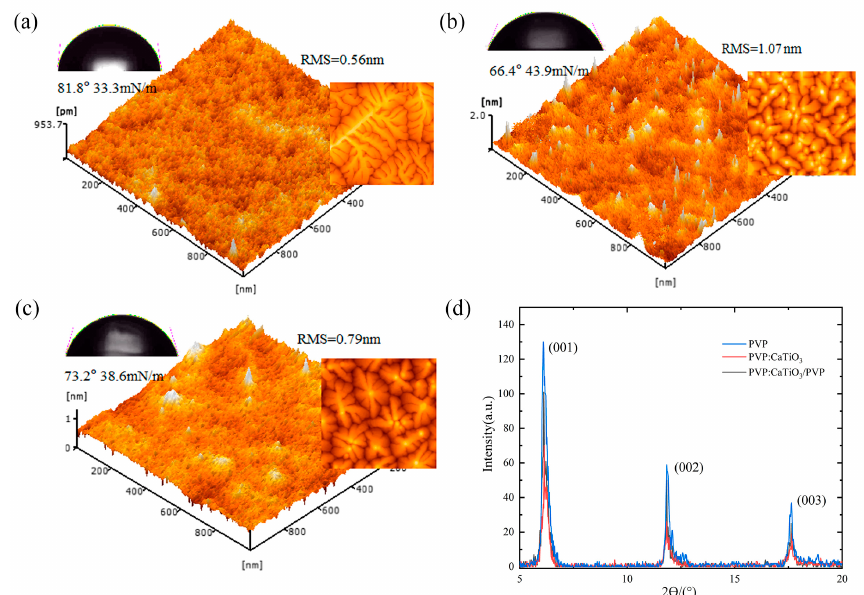
Figure 4. Three-dimensional topography images of (a) PVP, (b) PVP:CaTiO 3 NPs, (c) PVP:CaTiO 3 NPs (3 wt%) / PVP dielectric, respectively. Water contact angle (left), atomic force microscope (AFM) image of Pentacene grown on related dielectric. (d) X-ray diffraction (XRD) patterns of crystal phase structures of pentacene (40 nm) grown on different dielectrics.